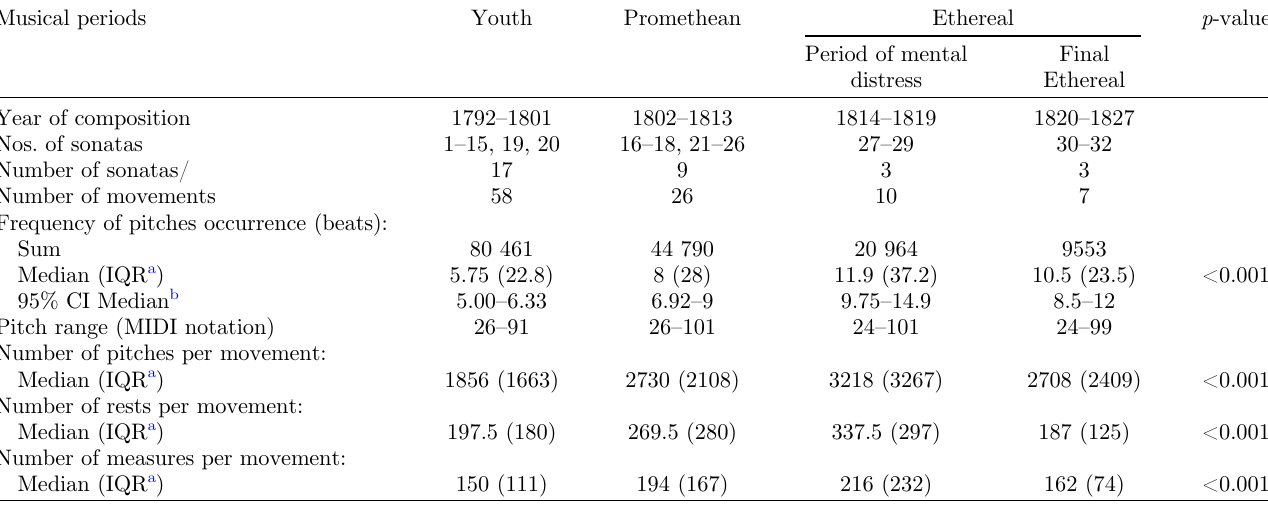
Table 1. Characteristics of the four periods of